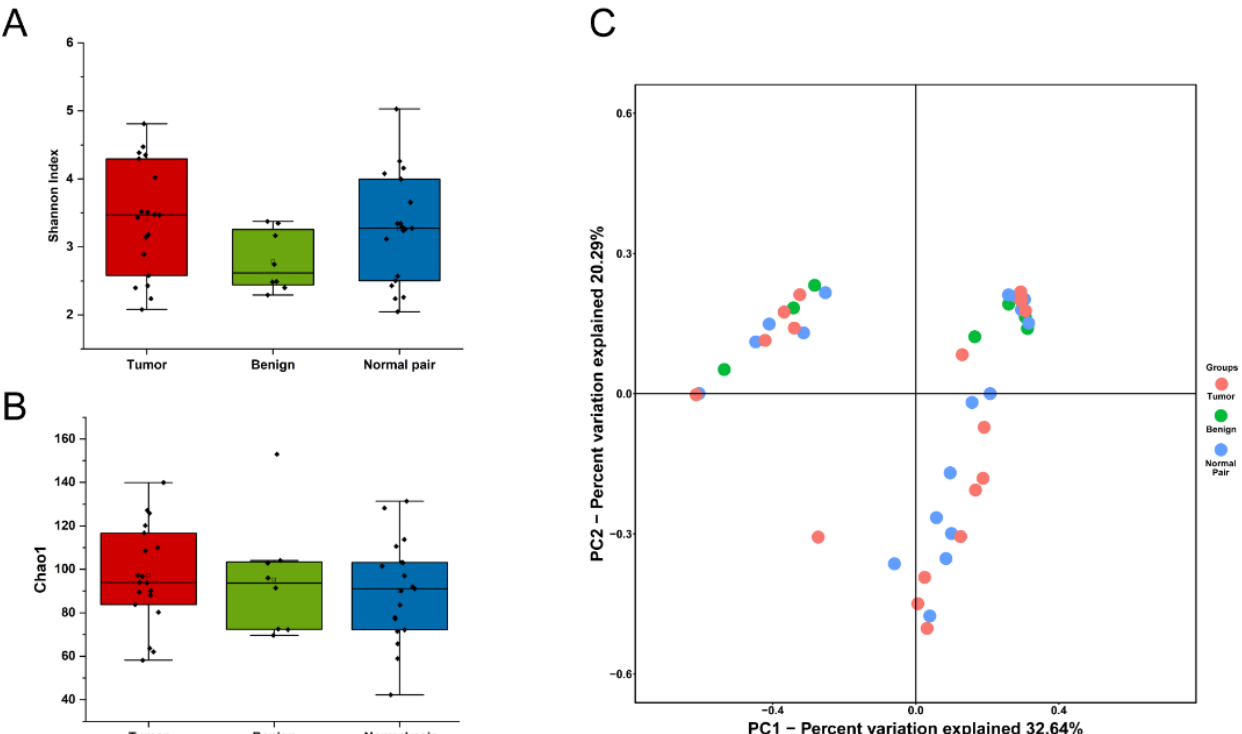
Figure 2. ( A ) Boxplot comparing Shannon index and ( B ) Chao1 between benign, normal pair, and breast tumor tissues (Shannon index, p = 0.171; Chao1, p = 0.645, one-way ANOVA). ( C ) PCoA plots show the clustering pattern of the three groups based on Bray–Curtis distance ( p = 0.699, Adonis).